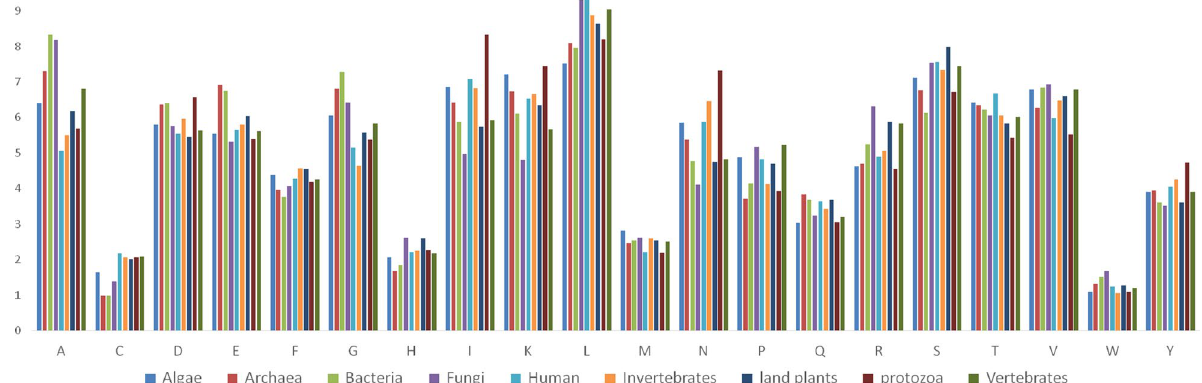
Figure 1. Individual amino acid composition of the virus proteome. Ala (A) amino acid was found to be highest in viruses of bacteria and fungi and lowest in the human host. Similarly, Ile (I) amino acid was found highest in the virus proteome of the protozoan host. The letters in the X-axis represent the initials of 20 essential amino acids. The graph was generated using Microsoft excel version Small peptides encoded in viral genomes. Viruses were also found to encode small peptides. Murine hepatitis virus (vertebrate host) was found to encode the smallest peptide (CAA28656.1) in the known virus kingdom with only 5 amino acids, M-S-S-T-T. A putative NTPase/helicase (AIW68525.1) in common midwife toad virus was found to encode seven amino acids, M-L-I-S-L-S-E. Hypothetical protein (AHZ10898.1) in the protozoan Leishmania aethiopica RNA virus was found to encode eight amino acids, M-I-Q-C-S-T-V-A. Hypo- thetical protein (AAQ13720.1) in the archaea His 1 virus was found to encode 15 amino acids, M-Q-M-Q-E-K- G-W-K-I-I-I-E-E-Q, and hypothetical protein phiC2p81 (ABE99541.1) of the Clostridium virus was found to encode a small peptide of 15 amino acids, M-G-I-S-G-E-K-L-G-N-F-L-I-F-K. The fungal Sclerotinia sclerotio- rum fusarivirus 1 was found to encode a small peptide of 28 amino acids (hypothetical protein, AKJ26311.1). Viruses exhibit host‑specific amino acid composition. An analysis of 1.713 million viral protein sequences from 19,128 virus proteomes across many different hosts was conducted. The viruses were grouped according to their host. The host groups were Algae (99), Archaea (555), Bacteria, (10,116) Fungi (312), Human (540), Invertebrate (1956), Land plants (2546), Protozoa (87), and Vertebrates (2917). The amino acid composi- tion in the different virus proteomes was analysed to characterize host-specific amino acid distribution (Sup- plementary Table 1). Cys (2.18%), Leu (9.37%), and Thr (6.669%) amino acids were in the highest percentage in human virus proteomes (Fig. 1). Ala (8.331%) and Gly (7.285%) were found in the greatest abundance in bacterial viruses (Fig. 1). The highest percentage of Asp (6.564%), Ile (8.333%), Lys (7.455%), Asn (7.314%), and Tyr (4.723%) was found Protozoan viruses; Glu (6.908%) and Gln (3.827%) were the most abundant in Archaea viruses, while His (2.626%), Arg (6.307%), Val (6.935%), and Trp (1.680%) were most abundant in fungal viruses (Fig. 1, Supplementary Table 1). Cys (0.983%), His (1.680%), and Pro (3.728%) amino acids were least abundant in Archaea viruses. Glu (5.310%), Ile (4.972%), Lys (4.795%), Asn (4.111%), and Tyr (3.525%) exhibited their lowest abundance in fungal viruses. The lowest percentage of Phe (3.755%) and Ser (6.123%) was found bacterial viruses, Met (2.202%), Arg (4.540%), Thr (5.425%), and Val (5.520%) exhibited their lowest abundance in Protozoan viruses (Fig. 1,